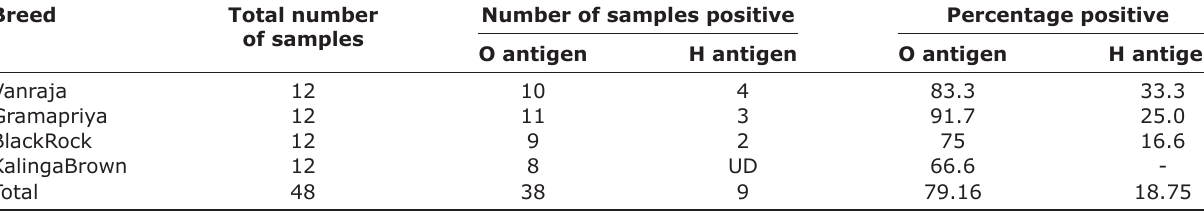
Table-5: Seroprevalence of specific antibodies against Salmonella in breeding hens. Breed Total number of samples